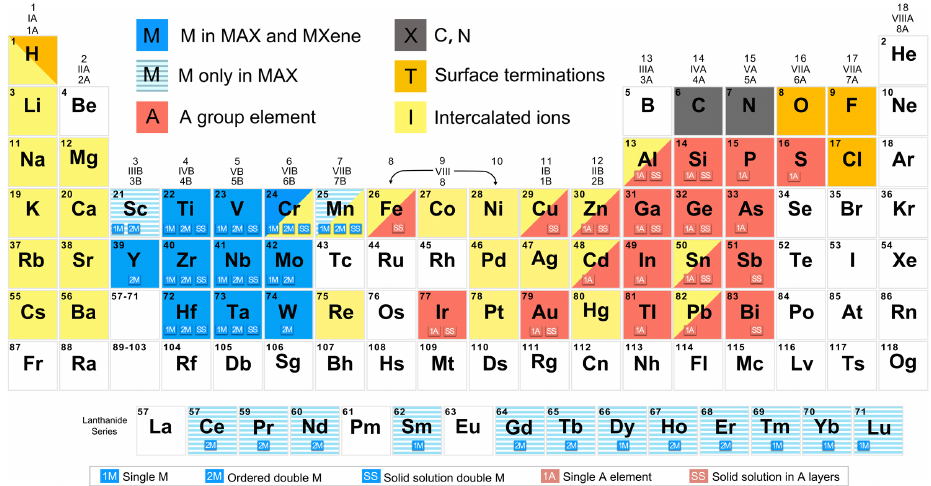
Figure 1: Constituent elements of MAX and MXenes and their intercalation ions. The blue background elements show reports only in the MXene precursor (MAX phase) and have not been synthesized in MXenes. The elements on the red background are the A element of MAX and may be selectively etched to make MXenes. The yellow background shows the cations that have been embedded in MXenes to date